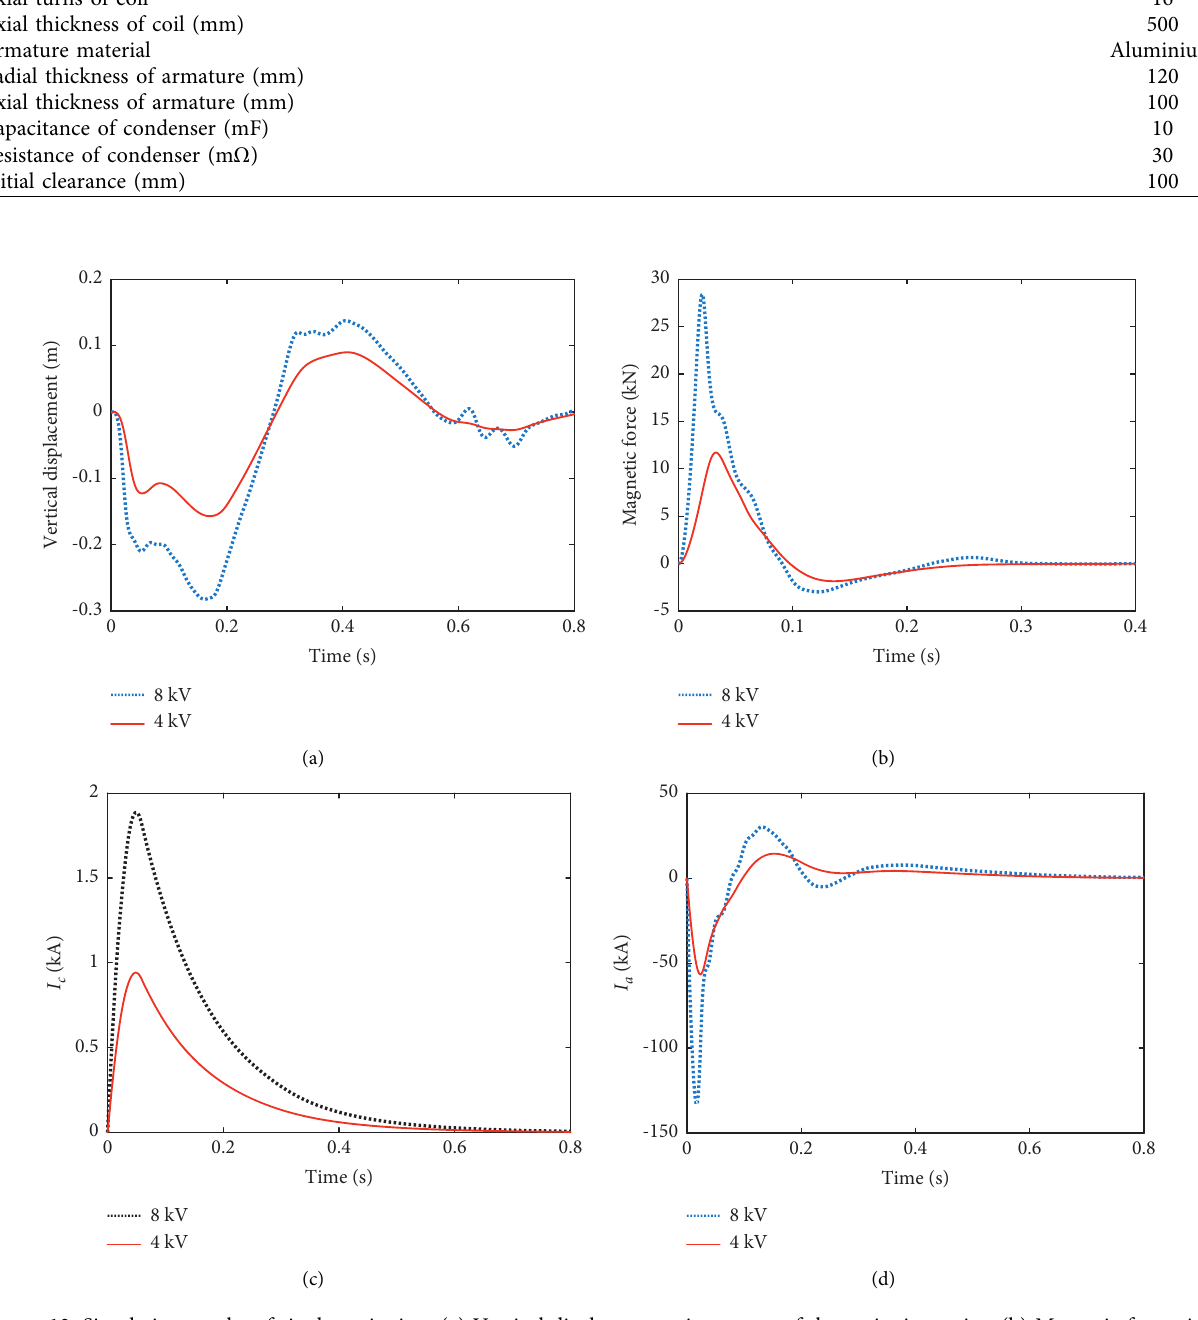
Figure 13: Simulation results of single excitation: (a) Vertical displacement-time curve of the excitation point. (b) Magnetic force-time curve. (c) Current in the coil loop curve with time. (d) Induced eddy current of the armature curve with